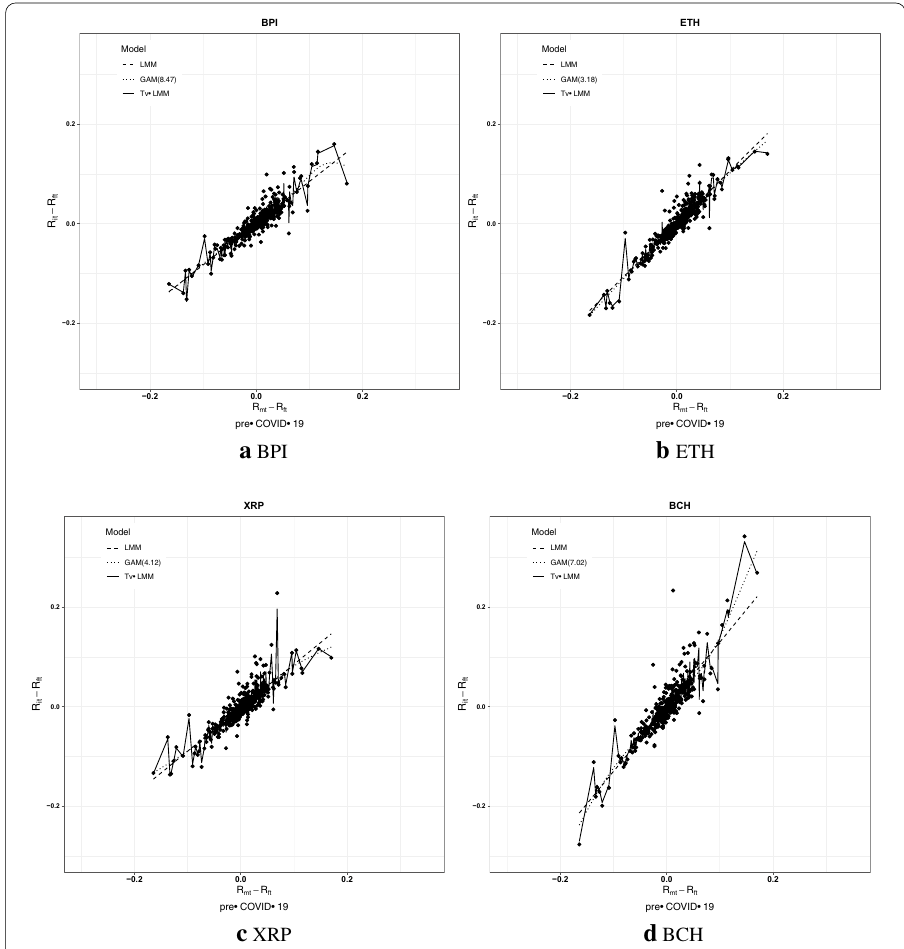
Fig. 3 The scatter plots of the four cryptocurrencies’ daily excess returns in the pre-COVID-19